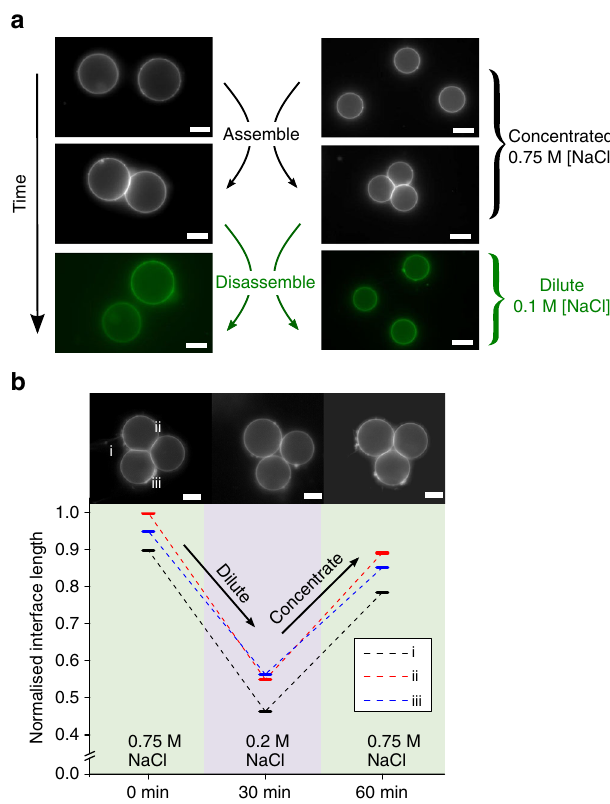
Fig. 3 Network modulation using salt concentration. a Networks were dismantled simply by reducing NaCl concentration in the exterior by dilution with water. Full detachment occurred after c. 45 min. b VIM length was dynamically altered by adjusting NaCl concentration over time, as shown by the relative lengths of the three interfaces in a three-vesicle network. Salt concentration was reduced from 0.75 M to 0.2 M, then increased from 0.2 to 0.75 M after 30 min. Interface length was normalised relative to vesicle radius. Scale bar = 10 µ m for all